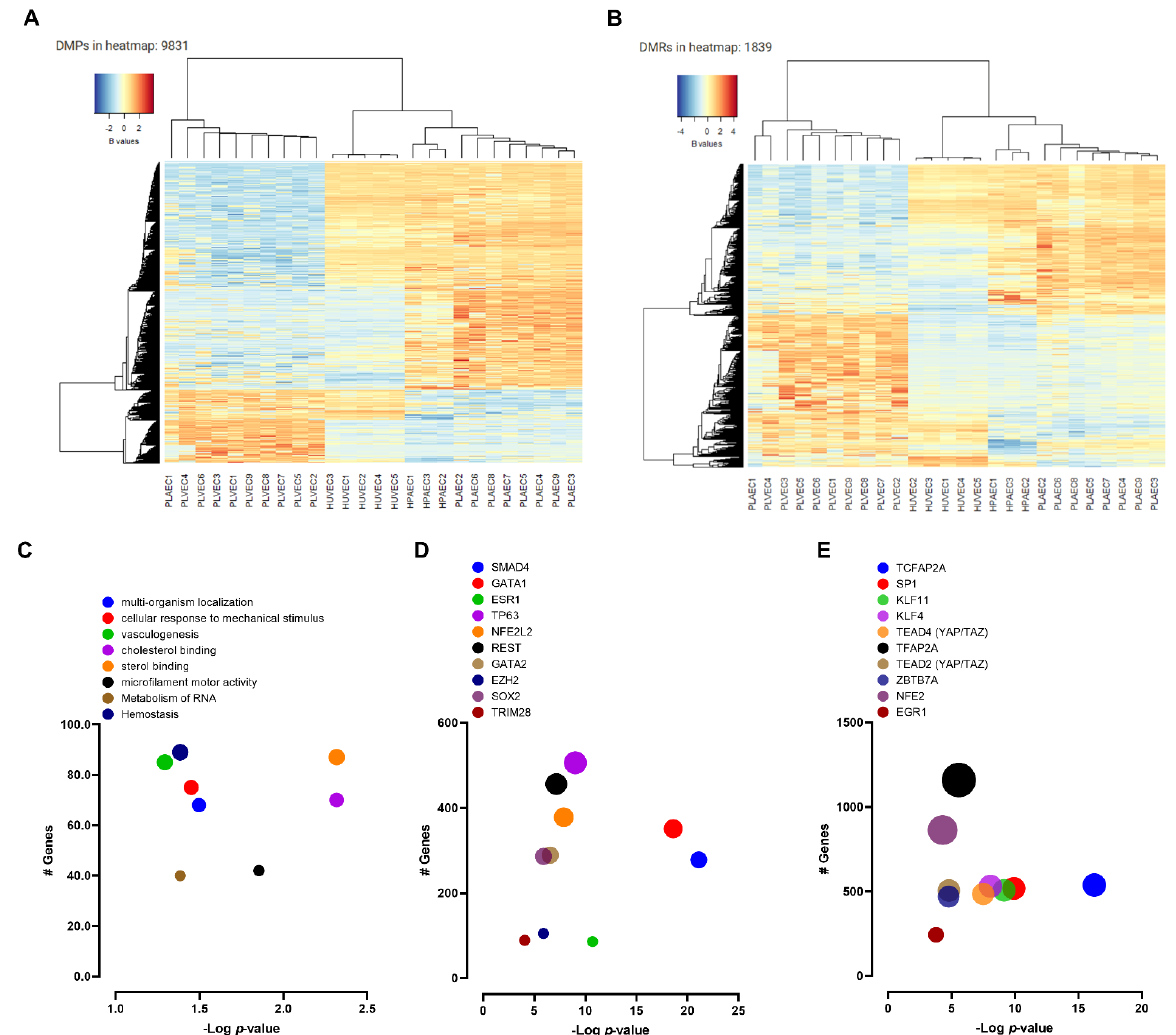
Figure 5. DNA methylation profile of arterial and venous endothelial cells. ( A ) Heatmap for DMPs and DMRs ( B ) in each sample. ( C ) Epigenomic-specific functional enrichment analysis bubble plots depict the enriched pathways and transcriptions factor generated by ENCODE ( D ) and TRANSFAC and JASPAR databases ( E ).